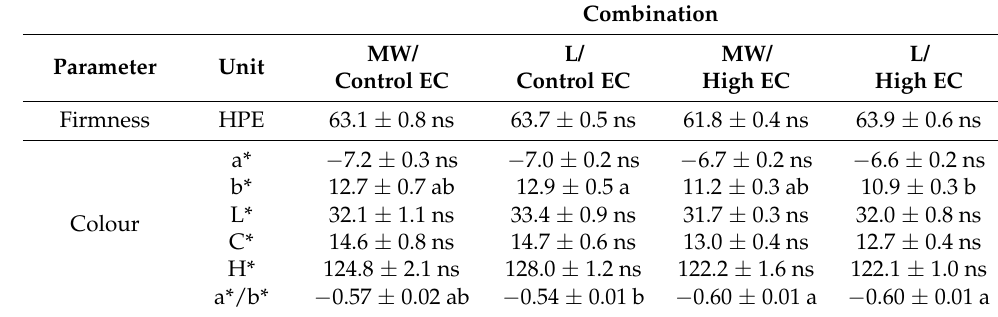
Table 4. CIE Lab-scale color and firmness of cucumber fruit (average from two